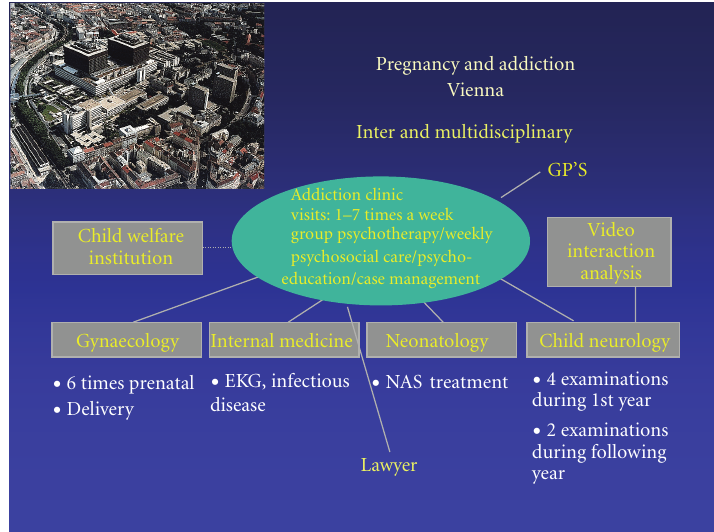
Figure 1: The multiprofessional team approach at the Addiction Clinic, University hospital of Vienna, Department of